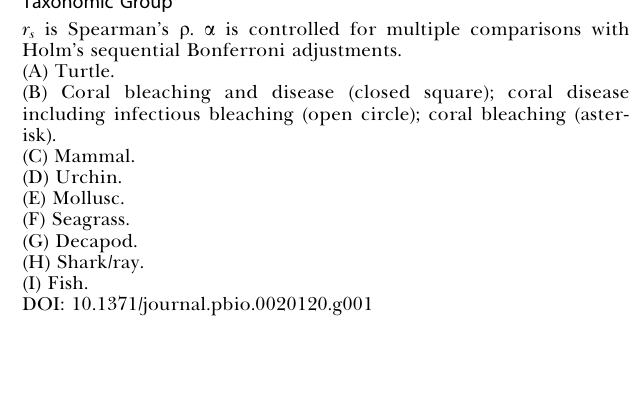
Figure 1. Percent of Literature Reporting Disease over Time in Each Taxonomic Group r s is Spearman’s q . a is controlled for multiple comparisons with Holm’s sequential Bonferroni adjustments. (A) Turtle. (B) Coral bleaching and disease (closed square); coral disease including infectious bleaching (open circle); coral bleaching (aster- isk). (C) Mammal. (D) Urchin. (E) Mollusc. (F) Seagrass. (G) Decapod. (H) Shark/ray. (I) Fish. DOI: 10.1371/journal.pbio.0020120.g001